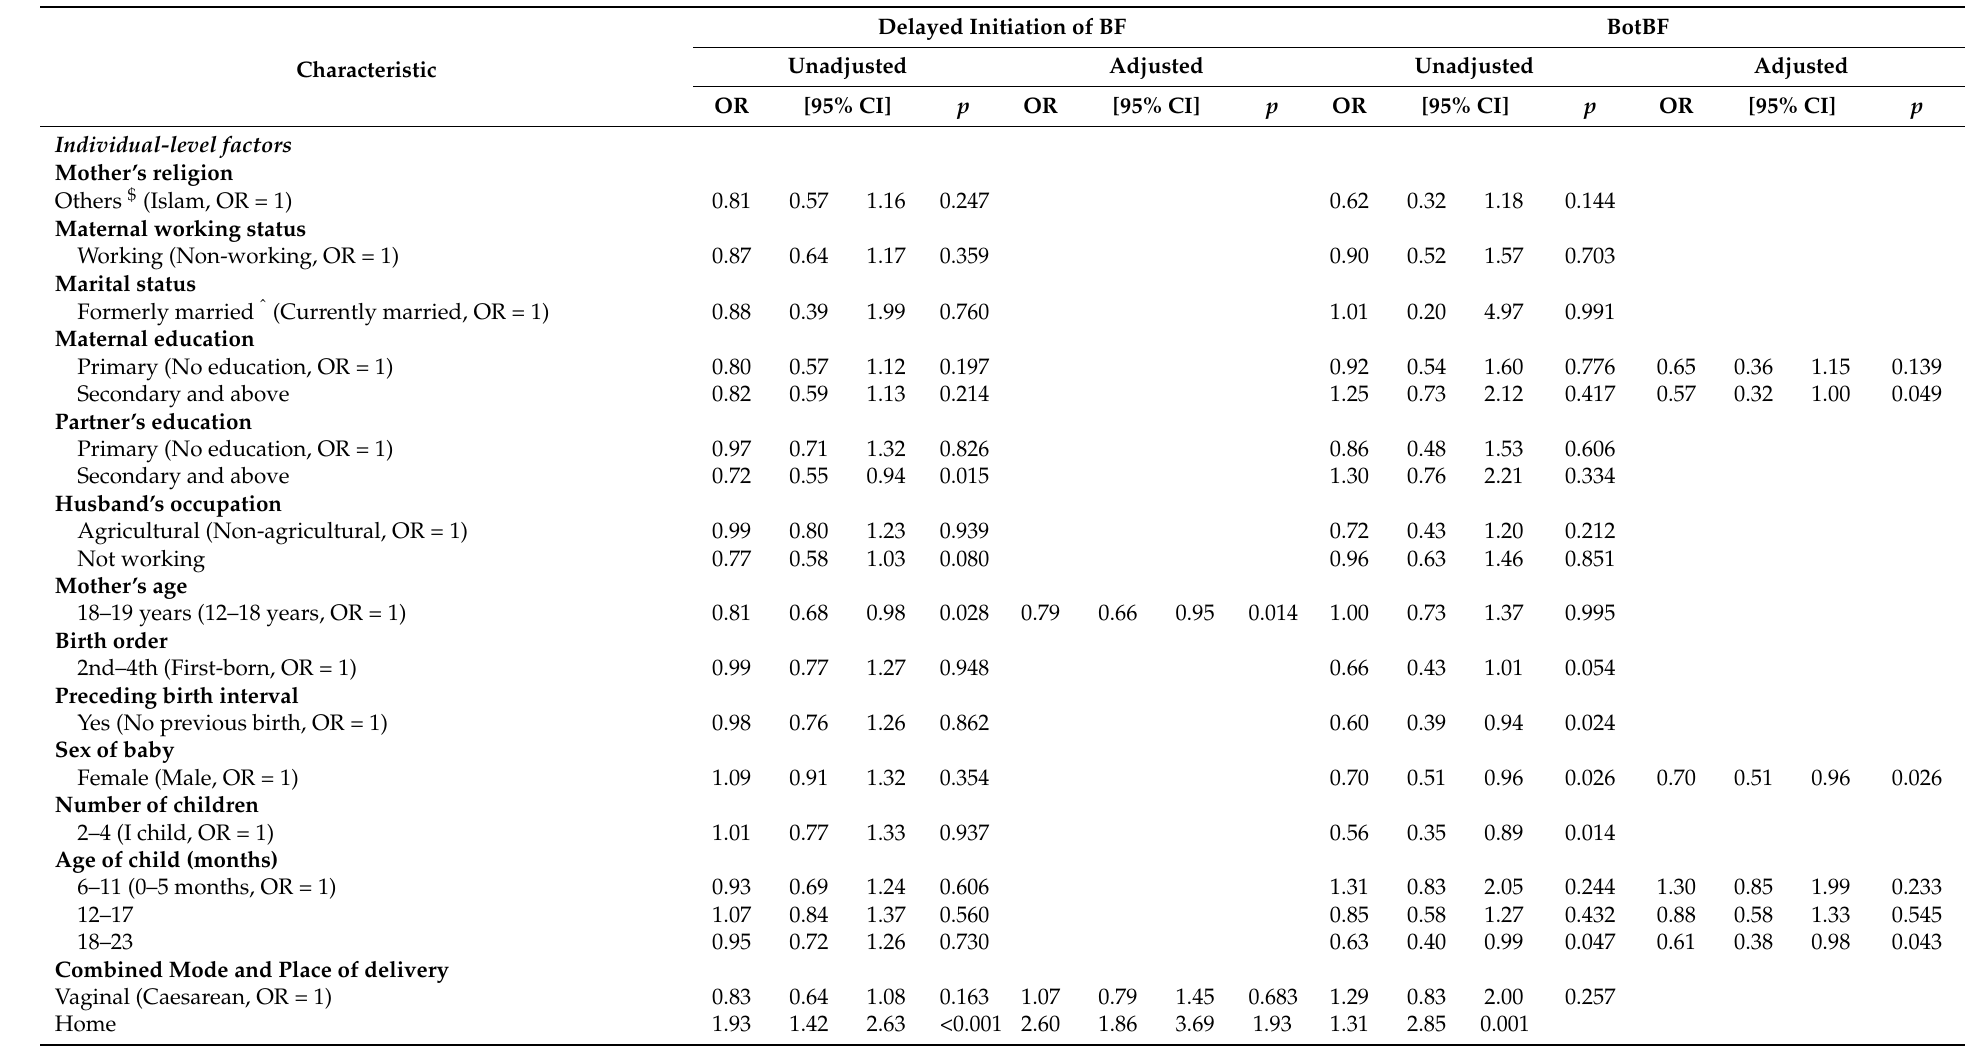
Table 3. Survey logistic modelling of a child bottle-fed and delayed initiation of BF—unadjusted and adjusted Odds Ratios, Bangladesh 2004–2014.